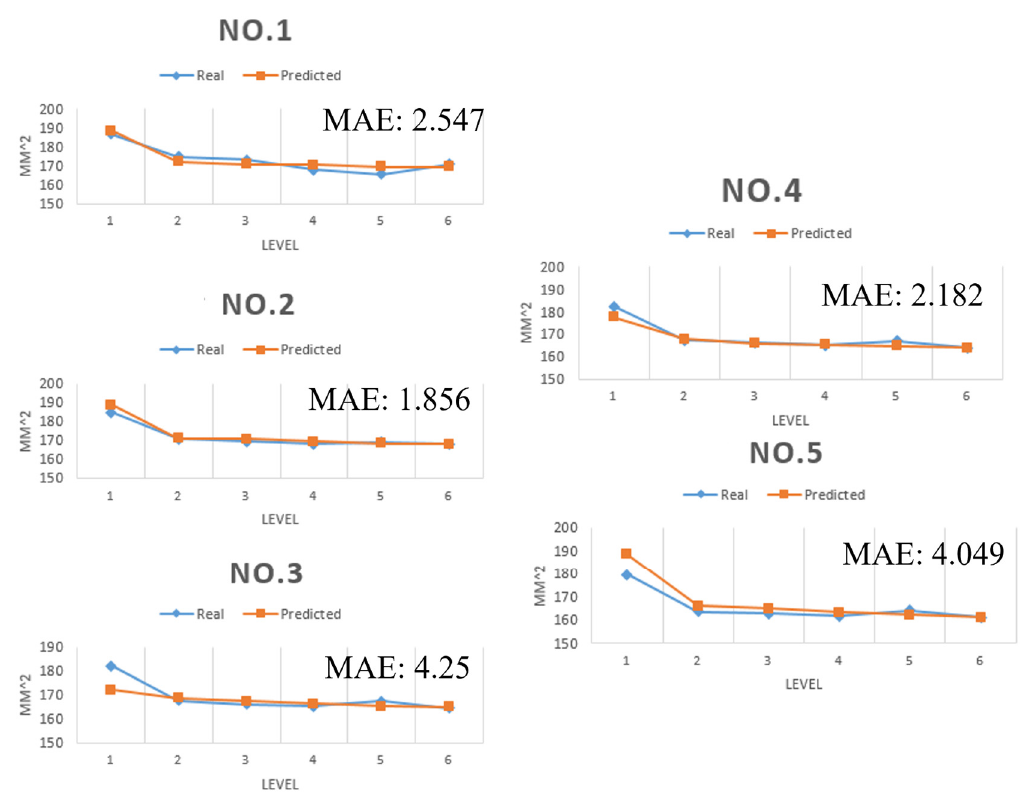
Figure 9. Comparisons of model predictions with experimental results. Table 3. Discrepancies between model predictions and experimental results.